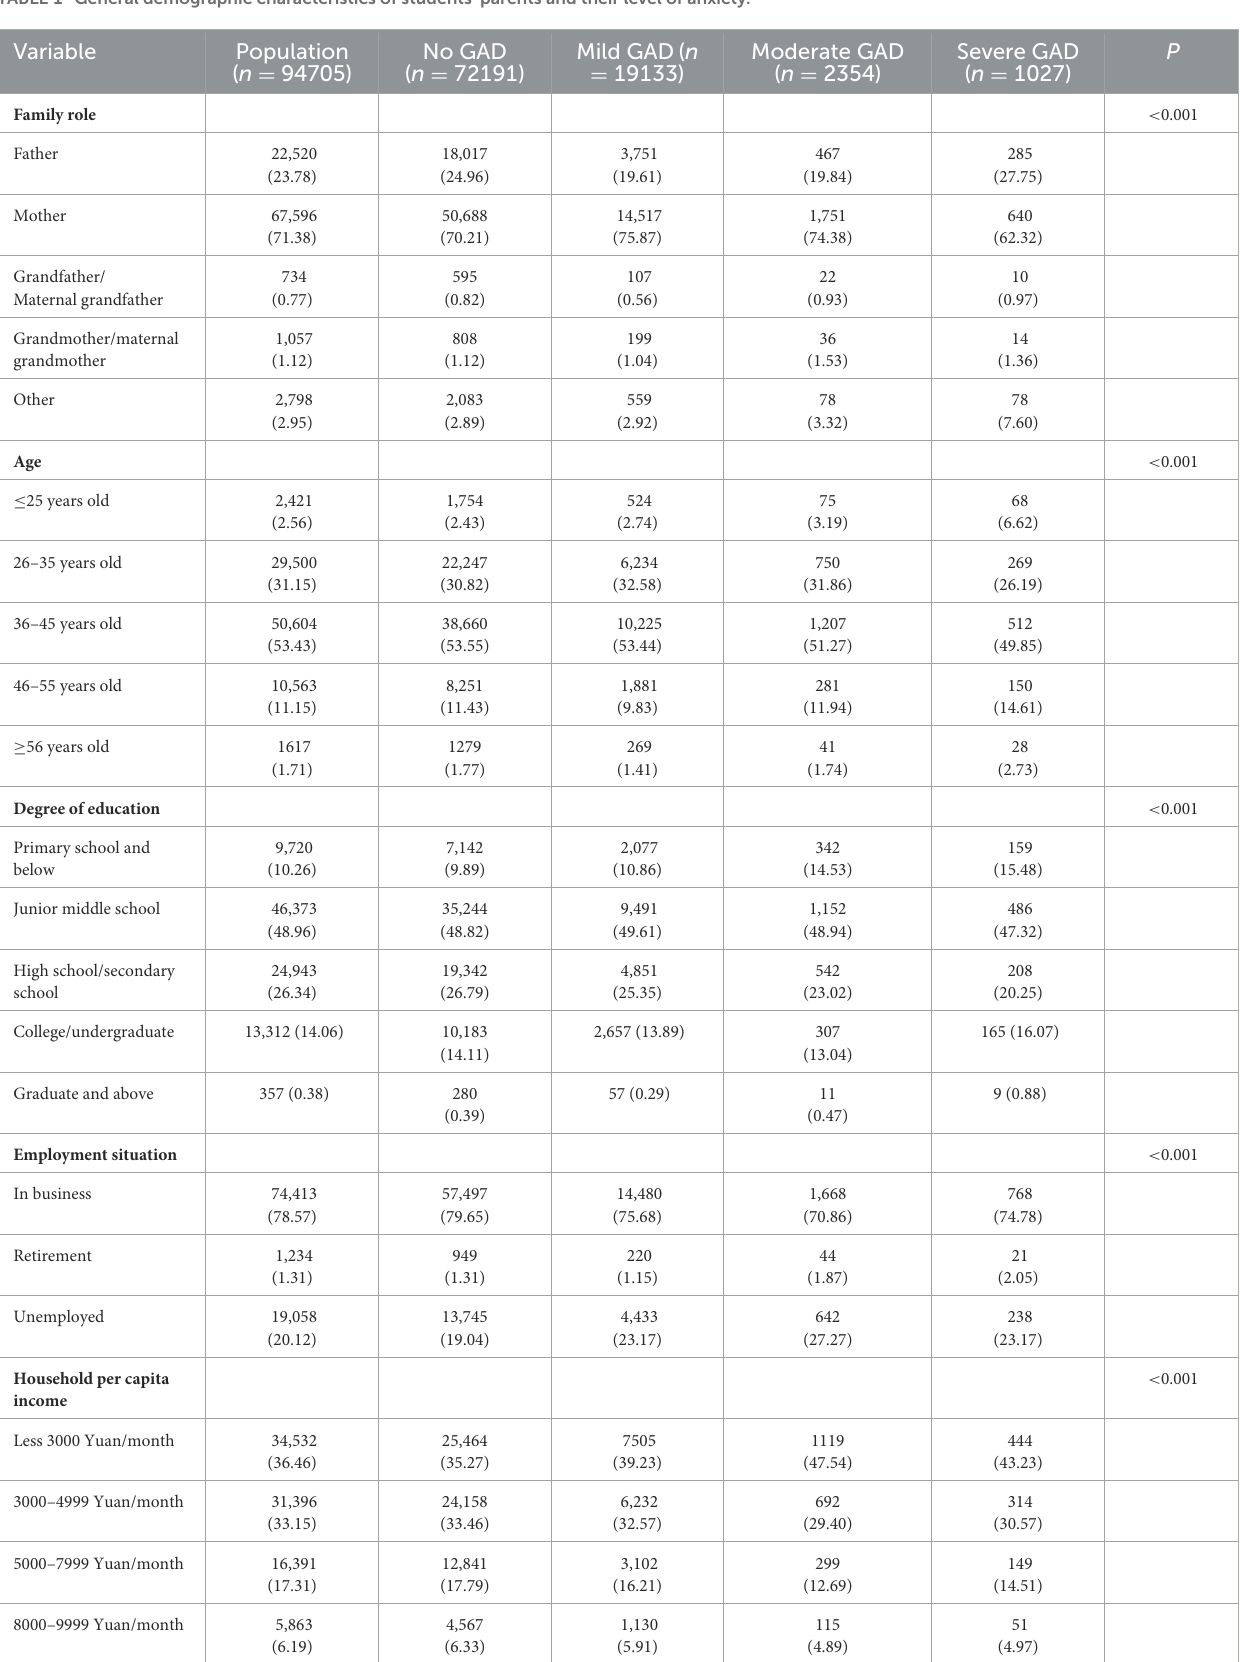
TABLE 1 General demographic characteristics of students’ parents and their level of